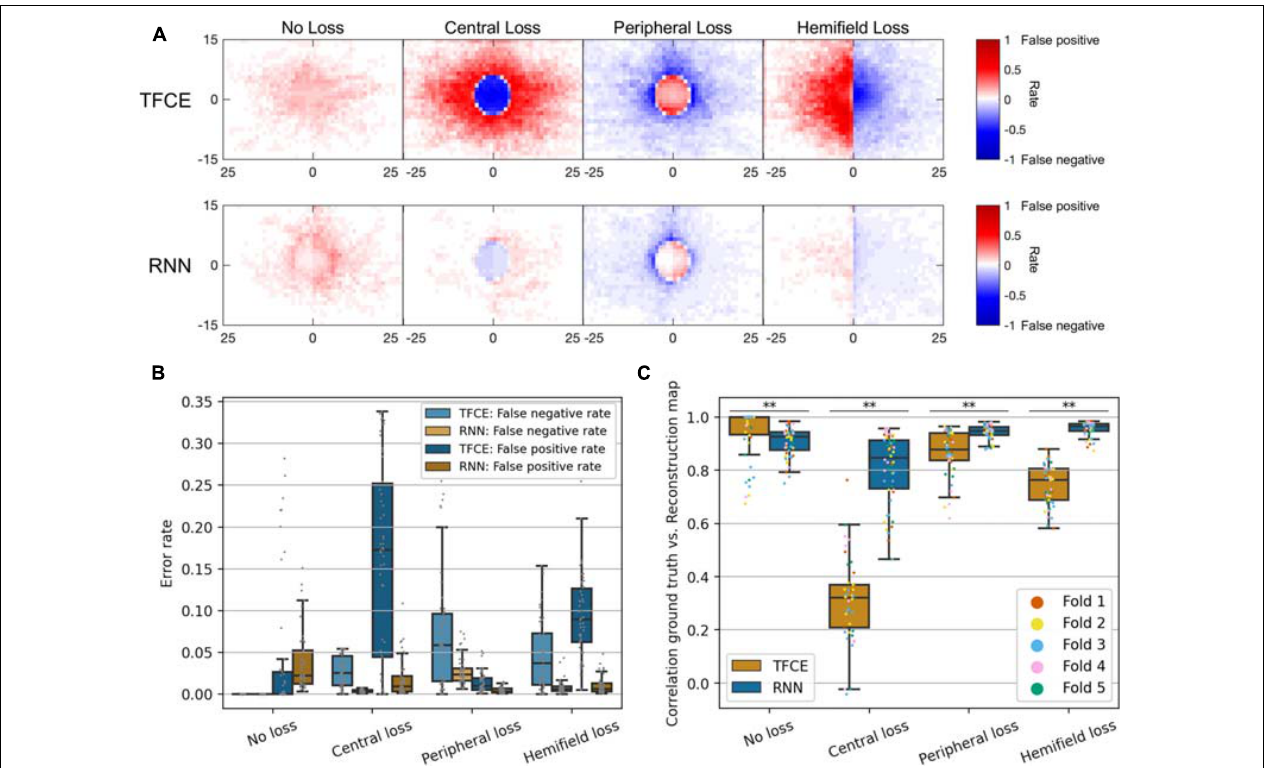
FIGURE 9 | (A) Spatial distributions of false positives and false negatives rates for each condition and for both TFCE and RNN methods. (B) Total error rates combining false positive rate and false negative rate of TFCE and RNN. (C) Comparison between TFCE and RNN visual field map reconstruction accuracies. The RNN method shows higher correlations with the ground-truth as well as being more consistent than the TFCE method. Statistically significant differences ( p < 0.001) are found across all tested conditions. Error bars show the 10th and 90th percentiles of each